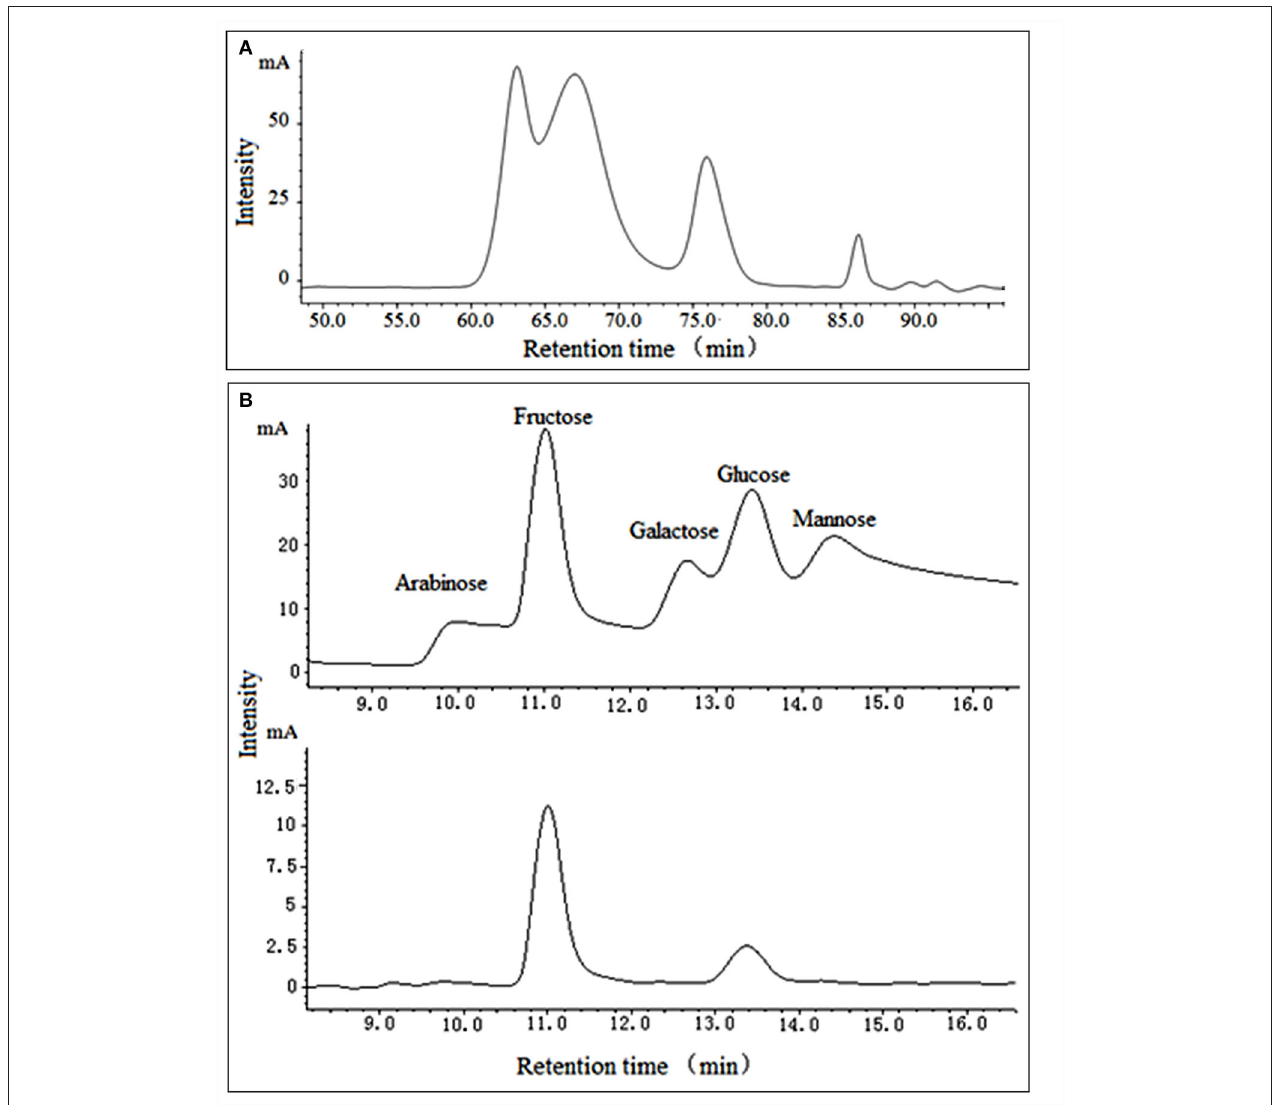
FIGURE 1 | M w distribution (A) and monosaccharide analysis (B) of purified GPs.